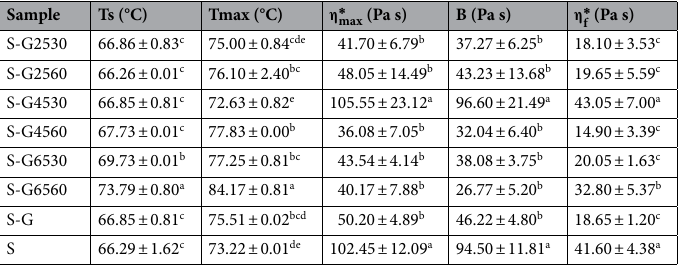
Table 4. Parameters obtained from the dynamic temperature sweep of thermal-ultrasound treated samples. a–e For each column, similar code letters are not significantly different at p <